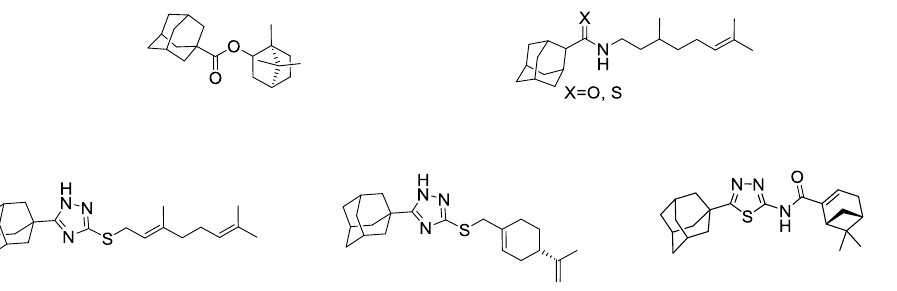
Figure 2. Adamantane derivatives connected with monoterpenoid residues via various linkers as TDP1 inhibitors.